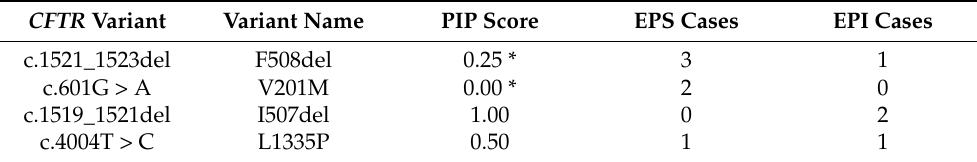
Table 2. Pancreatic insufficiency prevalence (PIP) score calculated on CFTR variants present two or more times in our Puerto Rican pediatric cohort.